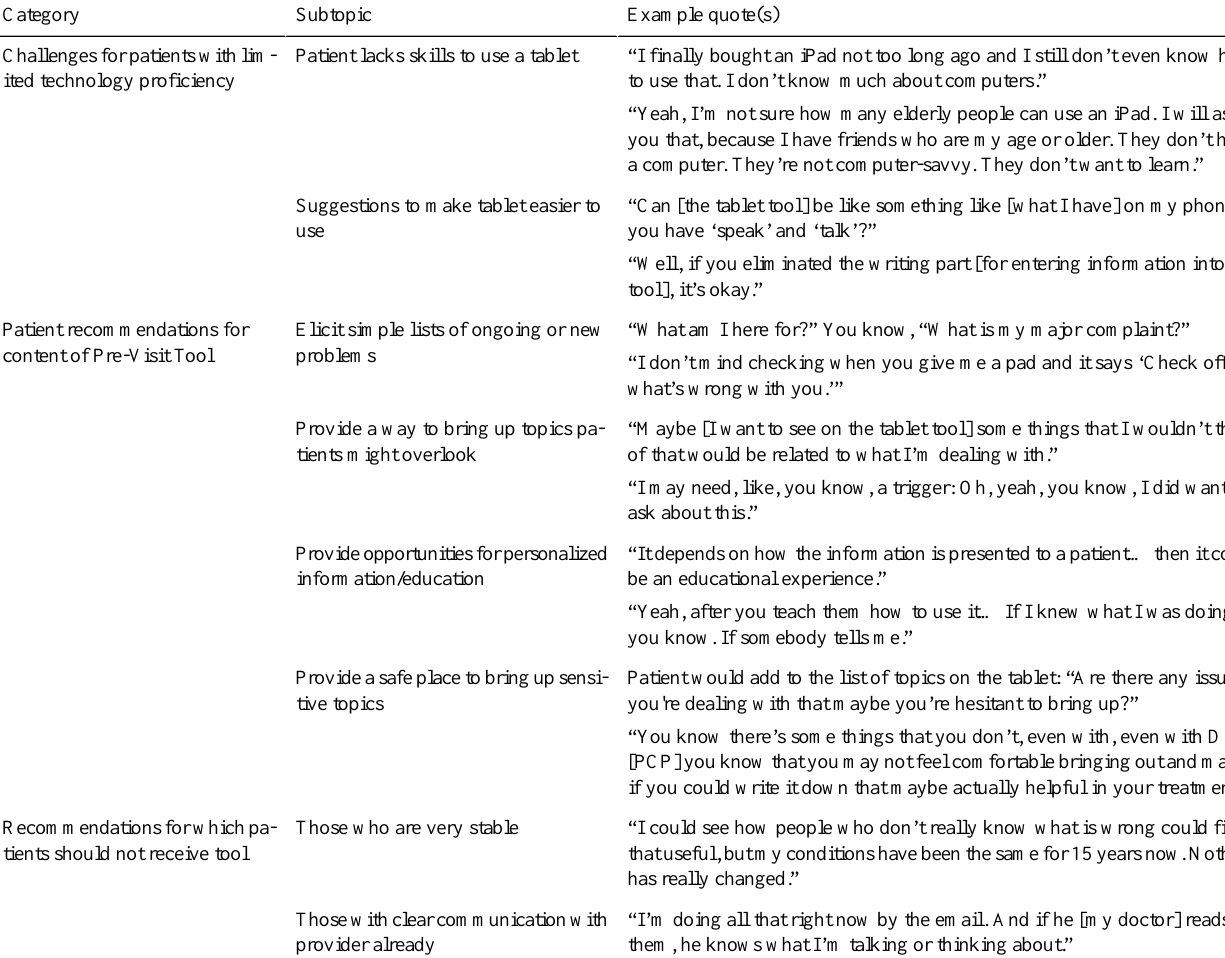
Table 1. Patient interview